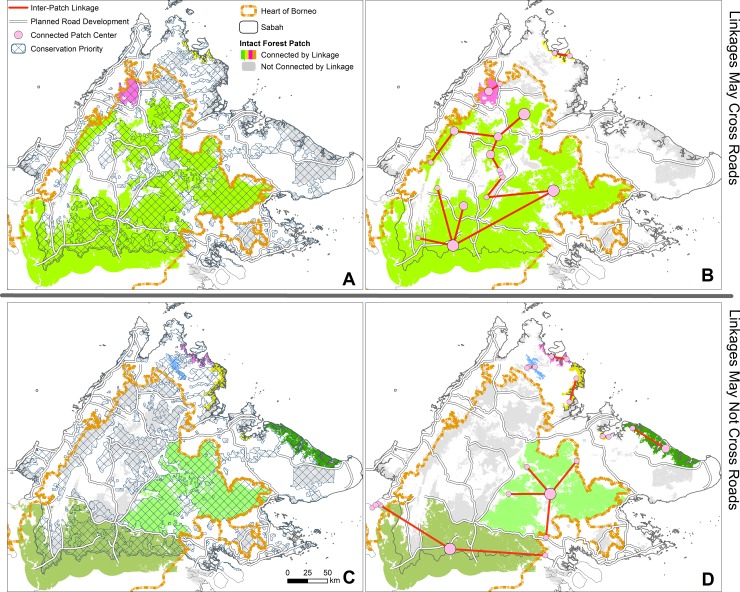
The 15 most important linkages for structural connectivity of intact forests across Sabah, northern Kalimantan, and eastern Sarawak, alongside intact forest patches and priority conservation areas, where linkages can (A, B) or cannot (C, D) cross planned roadways to connect proximate road-adjacent forests. Intact forest patches of a given single network are displayed in shades of green, pink, yellow and blue. Notes: The size of circular symbols for connected intact forest patches are indicative of patch area. Planned road developments are according to the Sabah Structure Plan 2033. Minor post-facto adjustments by regional conservation experts incorporated select corridors, Nipah palm areas, and remnant forest of the Lower Kinabatangan area into the priority conservation forests.